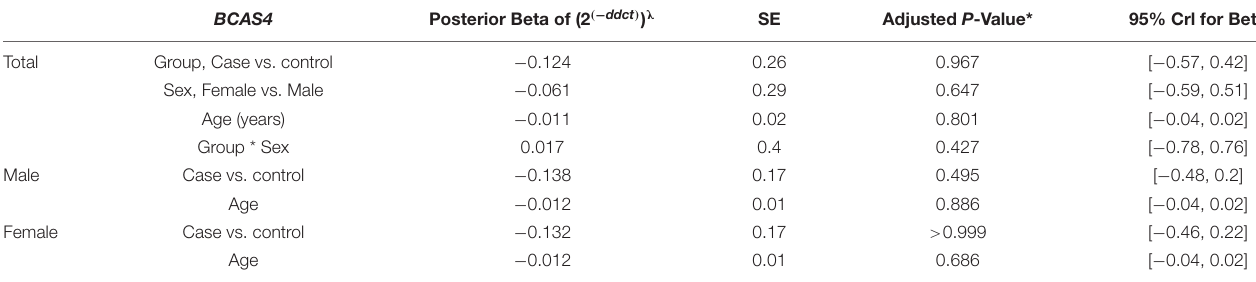
TABLE 2 | Relative levels of BCAS4 in AD cases and controls according to the Bayesian quantile regression model. BCAS4 Posterior Beta of (2 ( − ddct ) ) λ SE Adjusted P -Value* Group, Case vs. control